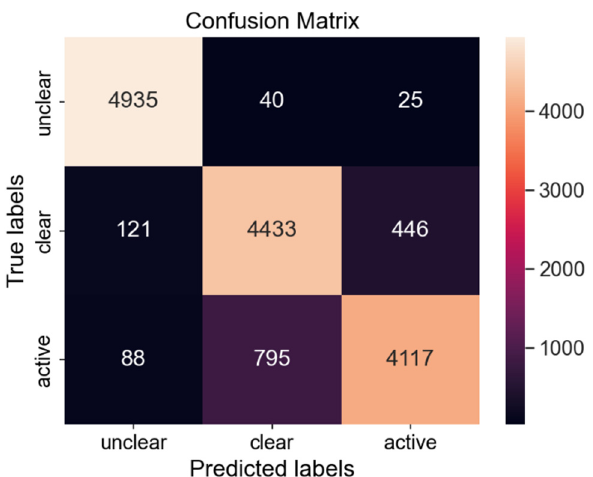
Figure 15. The confusion matrix overall folds of training the CNN for volcano image classification.